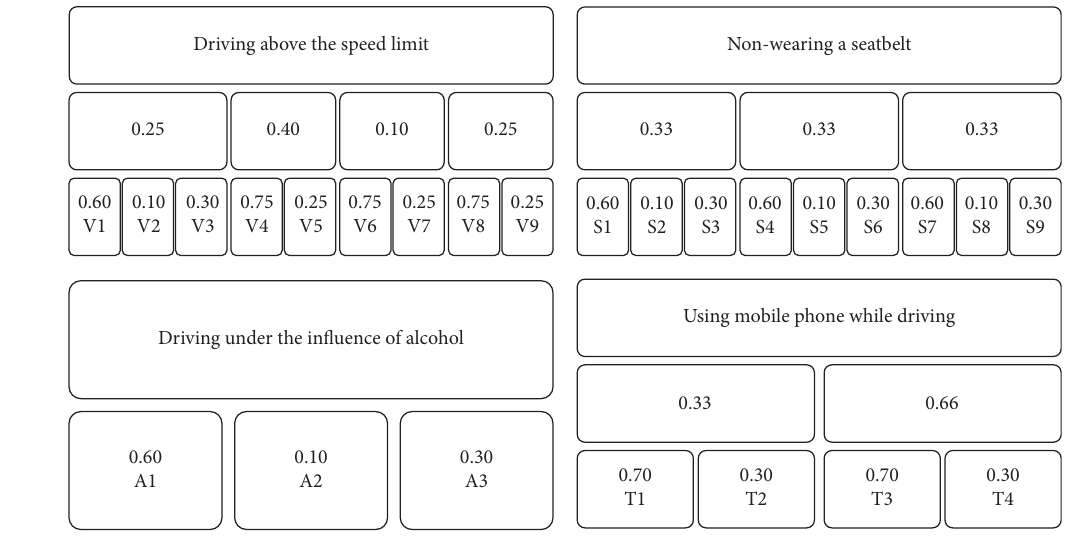
Figure 2: Internal weights of risk behavior. Table 7: Defuzzificated and normalized self-reported behavior